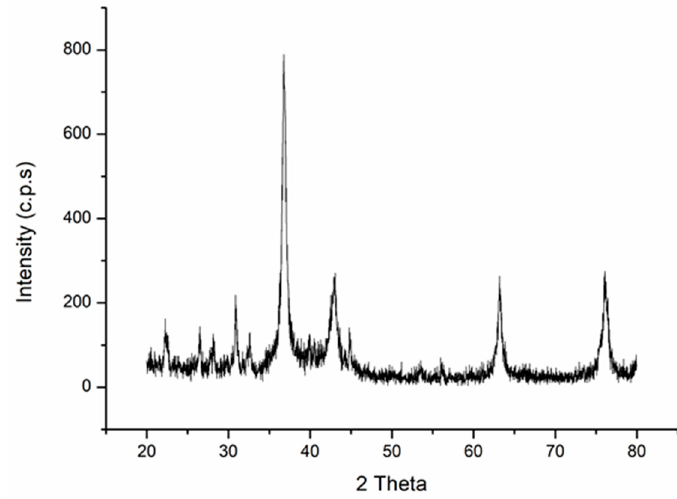
Figure 4. XRD pattern of silver nanoparticles.